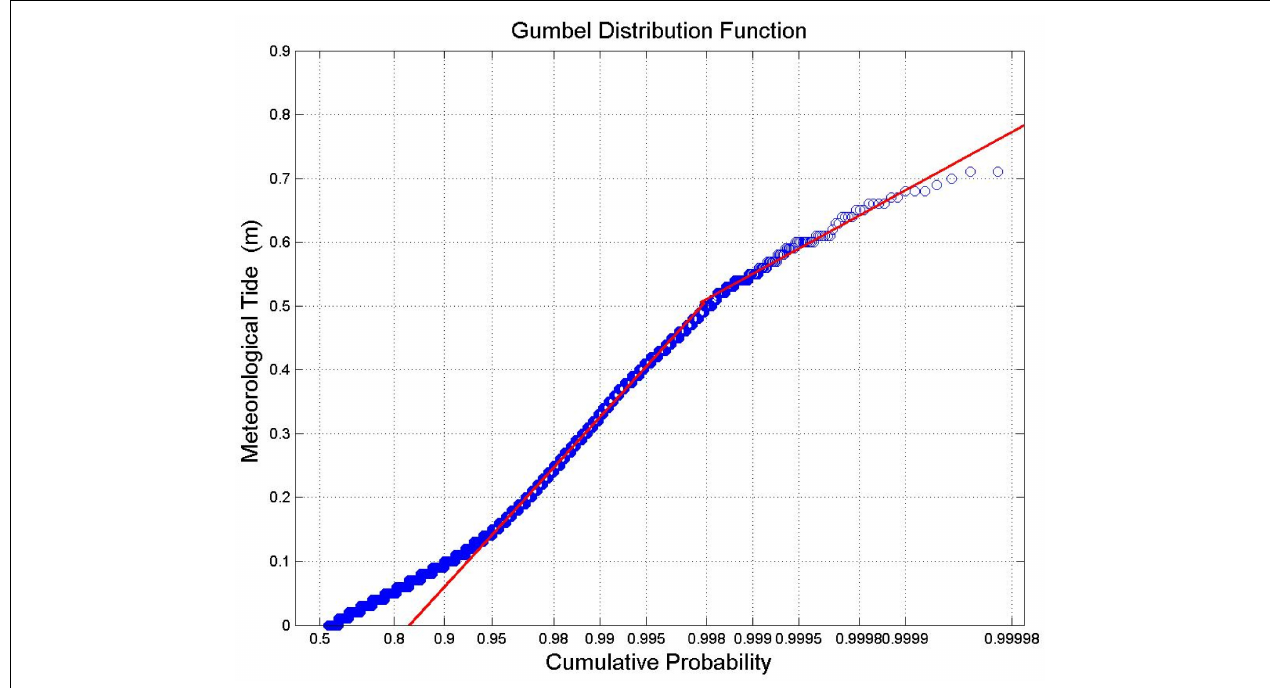
FIGURE 4 | Meteorological tide distribution function and its fit to a Gumbel distribution function. Open circles indicate the empirical distribution function of the meteorological tide and straight lines represent the two fitted Gumbel distribution functions.